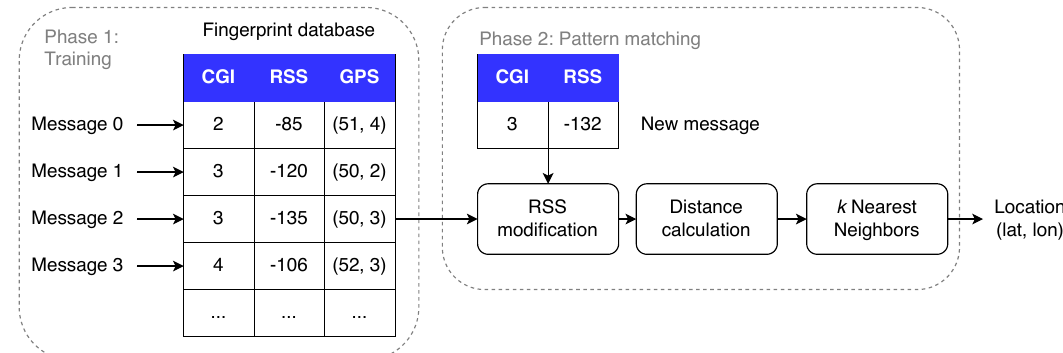
Figure 5. Procedure of the fingerprint-based k NN